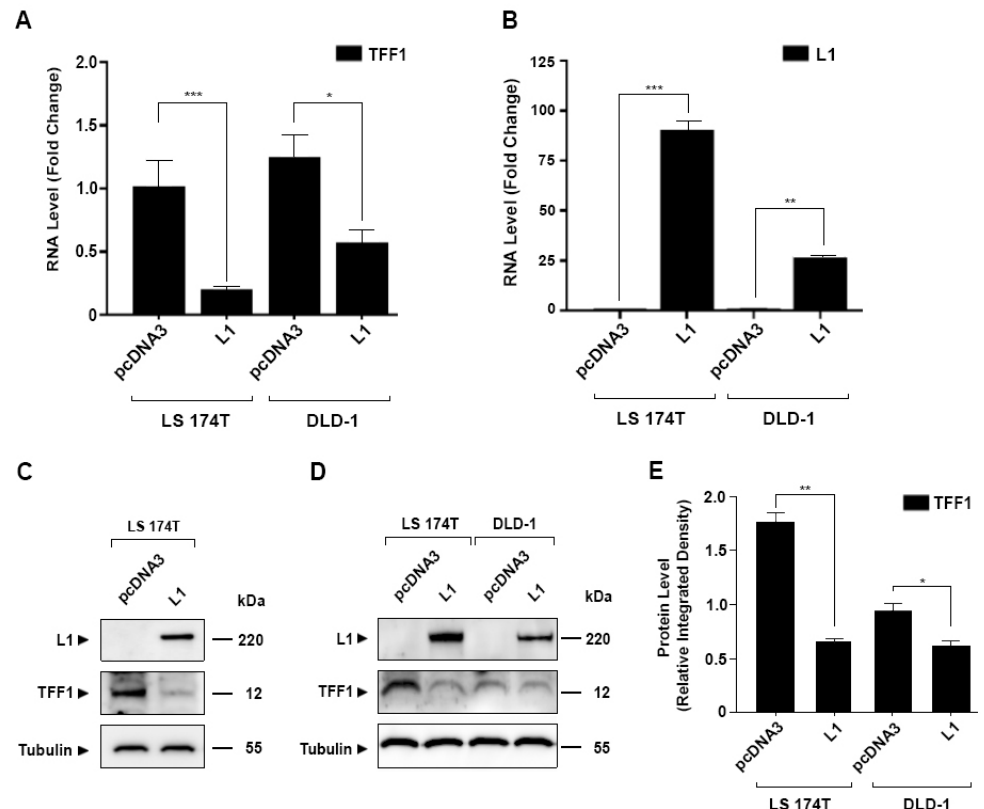
Figure 1. Suppression of TFF1 expression in CRC cells overexpressing L1. ( A ) The level of TFF1 RNA was determined in L1 overexpressing LS 174T and DLD-1 CRC cells; ( B ) L1 RNA levels were determined by RT-PCR in the cells described in ( A ); ( C , D ) the expression of TFF1 and L1 protein was determined by Western blotting in the cell lines described in ( A ). Tubulin served as loading control; ( E ) the intensity of the TFF1 bands shown in the Western blots of the different CRC cell lines ( D ) was determined by densitometric analysis of the gels shown in ( D ). Relative integrated band densities of TFF1 were calculated from triplicate gels, and the significance was determined using Student’s unpaired t -test. * p < 0.05, ** p < 0.01, *** p < 0.001. The uncropped blots are shown in Supplementary File S1.